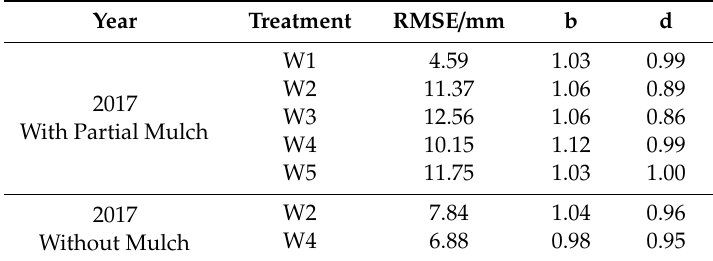
Table 5. Statistics of observed and estimated evapotranspiration in 2017 on partial mulched and non-mulched plots in Xinjiang, China.